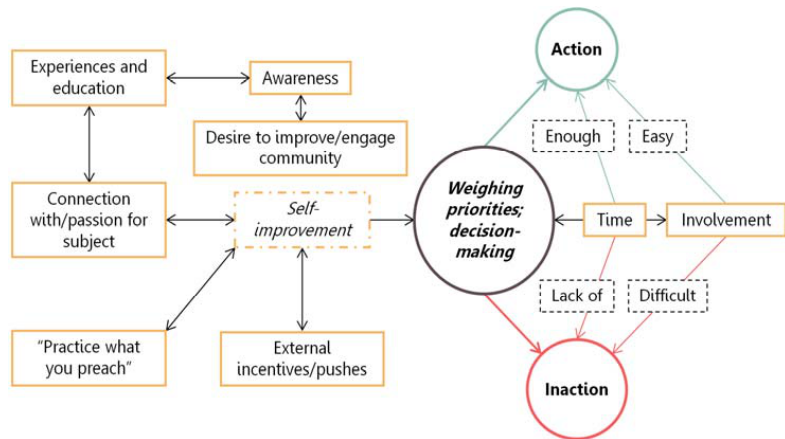
Figure 2. All the factors in the yellow boxes are things that motivate action or inaction. They all converge in the individual’s mind, where factors are prioritized and decisions are made to take action or not. On the left-hand side, almost all of these factors point to self-improvement, but the yellow dash-dot box represents that they do not necessarily have to flow through self-improvement (i.e., not all of these factors are based in an individual’s desire to improve oneself) in order to make it to the decision-making point of the framework. Double-headed arrows indicate a two-way